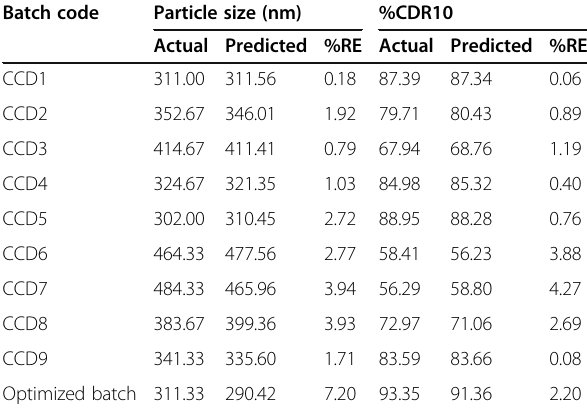
Table 5 Actual vs. predicted experiment value (*relative error) Batch